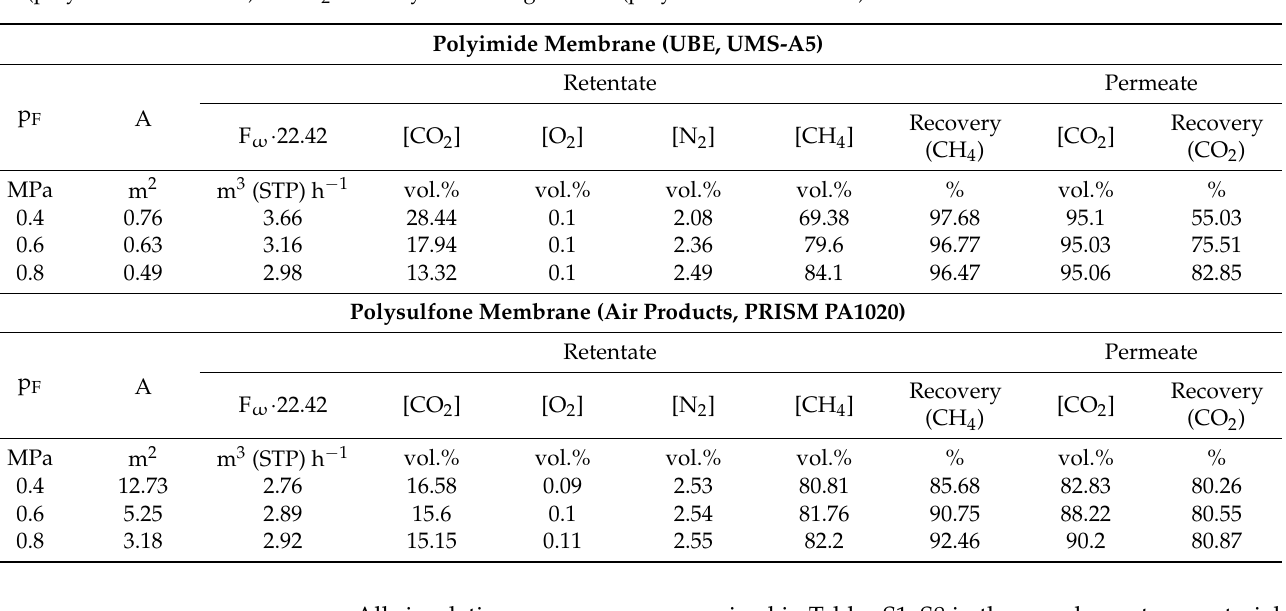
Table 4. Parameters in the first stage of the two-stage membrane system, when CO 2 concentration in this stage is 95 vol.% (polyimide membrane) or CO 2 recovery in this stage is 80% (polysulfone